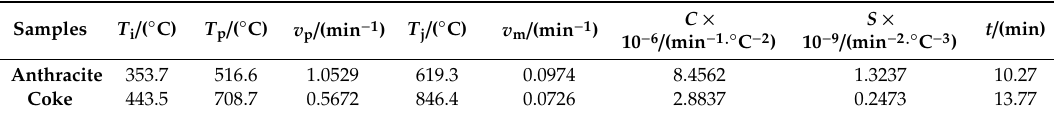
Table 4. Combustion characteristics of anthracite and coke powder.